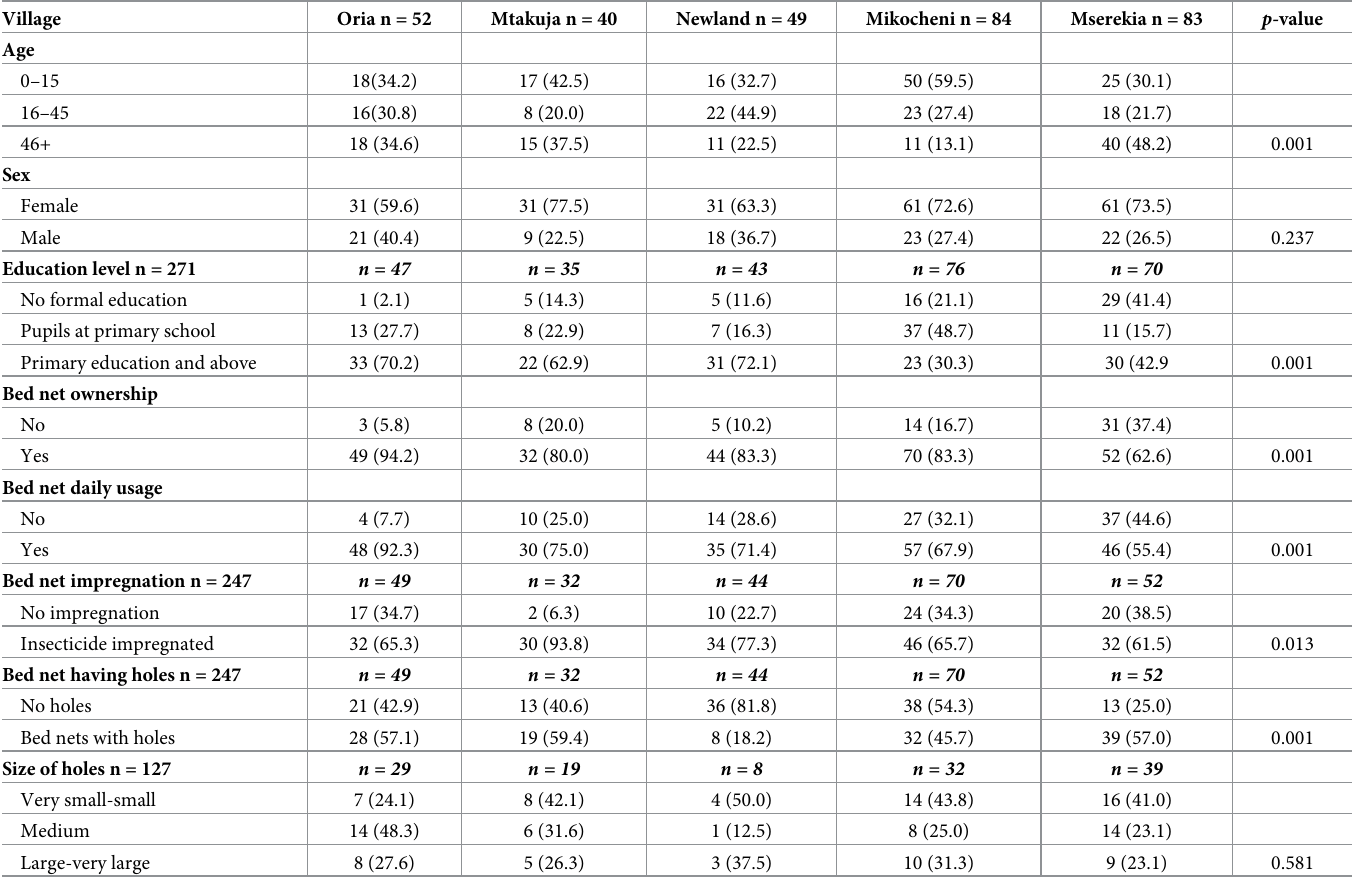
Table 2. Baseline characteristics of the study population by village of residence: N =